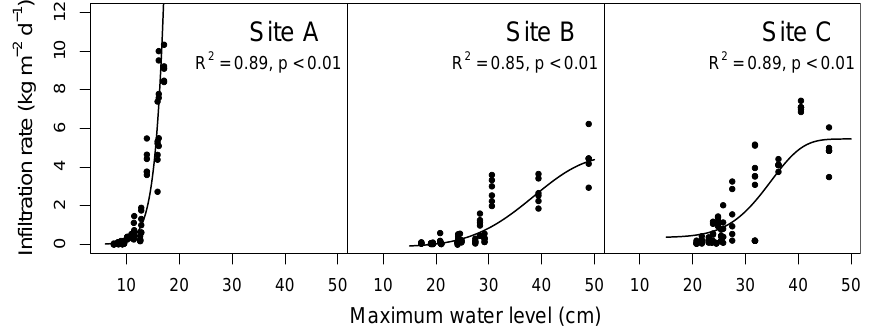
Fig. 6. Sediment infiltration rate in relation to the highest mean daily water level above the redds during the measurement week. The relationship at site B and C is described by a Weibull growth function.